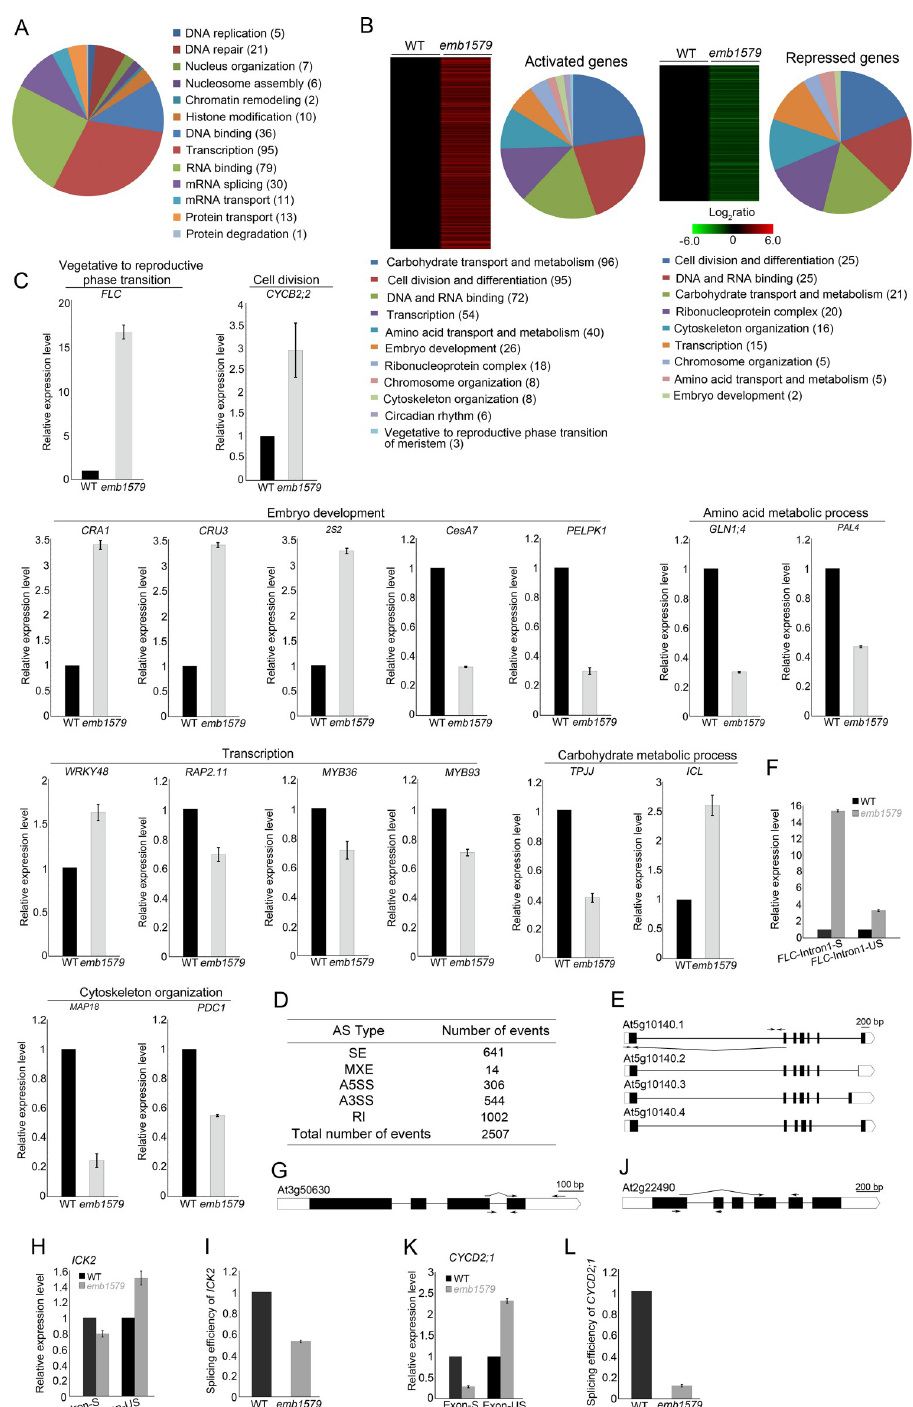
Fig 3. Loss of function of EMB1579 alters global transcription and mRNA splicing. ( A ) Identification and functional classification of proteins that cosediment with EMB1579 compartments. Proteins enriched in the EMB1579 cosedimentation fraction were analyzed by mass spectrometry. A full list of the proteins is presented in S1 Table. ( B ) EMB1579-activated and EMB1579-repressed genes. Seven-DAG WT and emb1579 seedlings were subjected to RNA- seq analysis. A full list of the up- and down-regulated genes is presented in S2 Table. ( C ) Validation of the altered expression of specific genes in emb1579 mutants. qRT-PCR was performed to confirm the changed expression levels of 17 different genes in emb1579 mutants, as originally revealed by RNA-seq analysis. Data are presented as mean ± s.e.m,